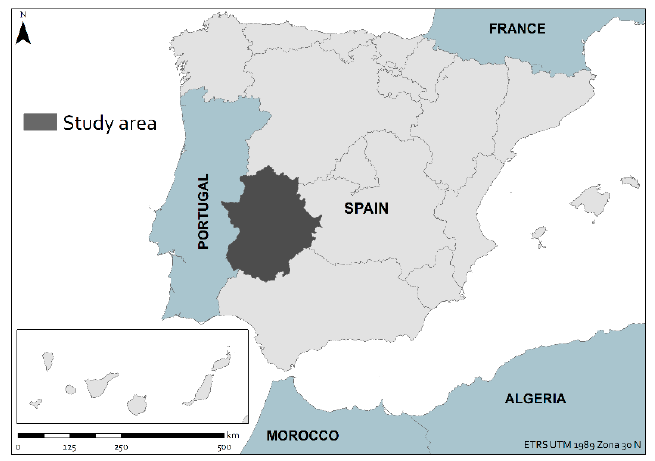
Figure 1. Autonomous Community of Extremadura, Spain (study area).